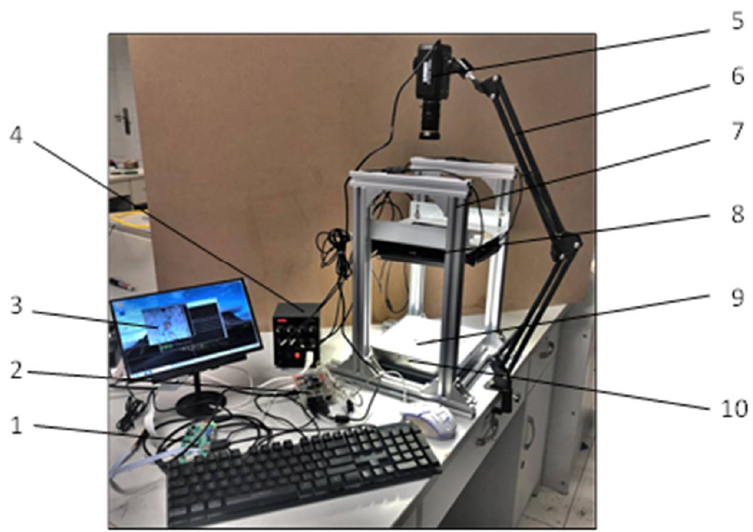
Figure 2. Photo of image-acquisition system. 1—Display driver board; 2—Raspberry PI 4B; 3—dis- play;4—Light source controller ; 5—camera; 6—camera fixer; 7—bench; 8—light source; 9—Seed cotton sample ； 10—material storage box.